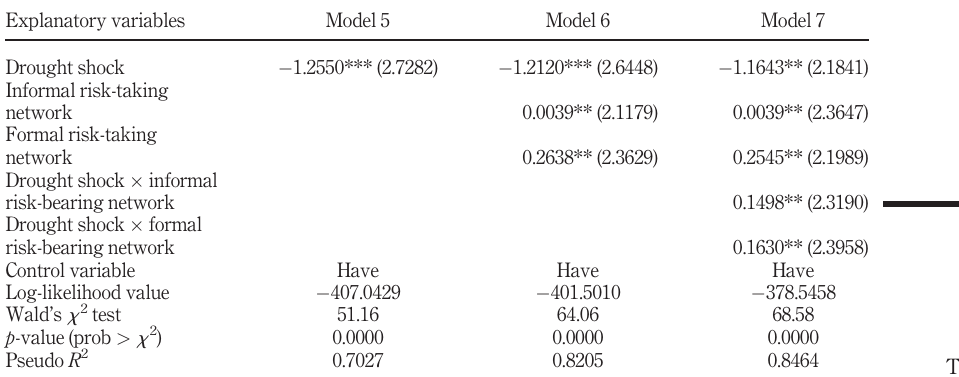
Table 5. Test results of robustness for models